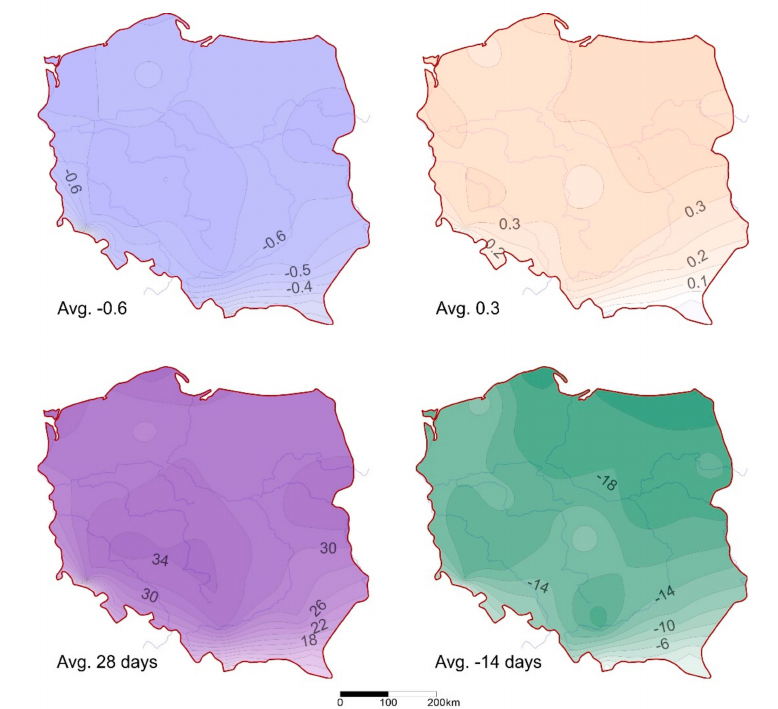
Figure 9. Correlation between the number of days with snow cover and North Atlantic Oscillation (NAO)/ Scandinavian pattern (SCAND) winter indices ( upper row ), and difference in snow cover duration between the negative and positive phase of NAO/SCAND ( lower row